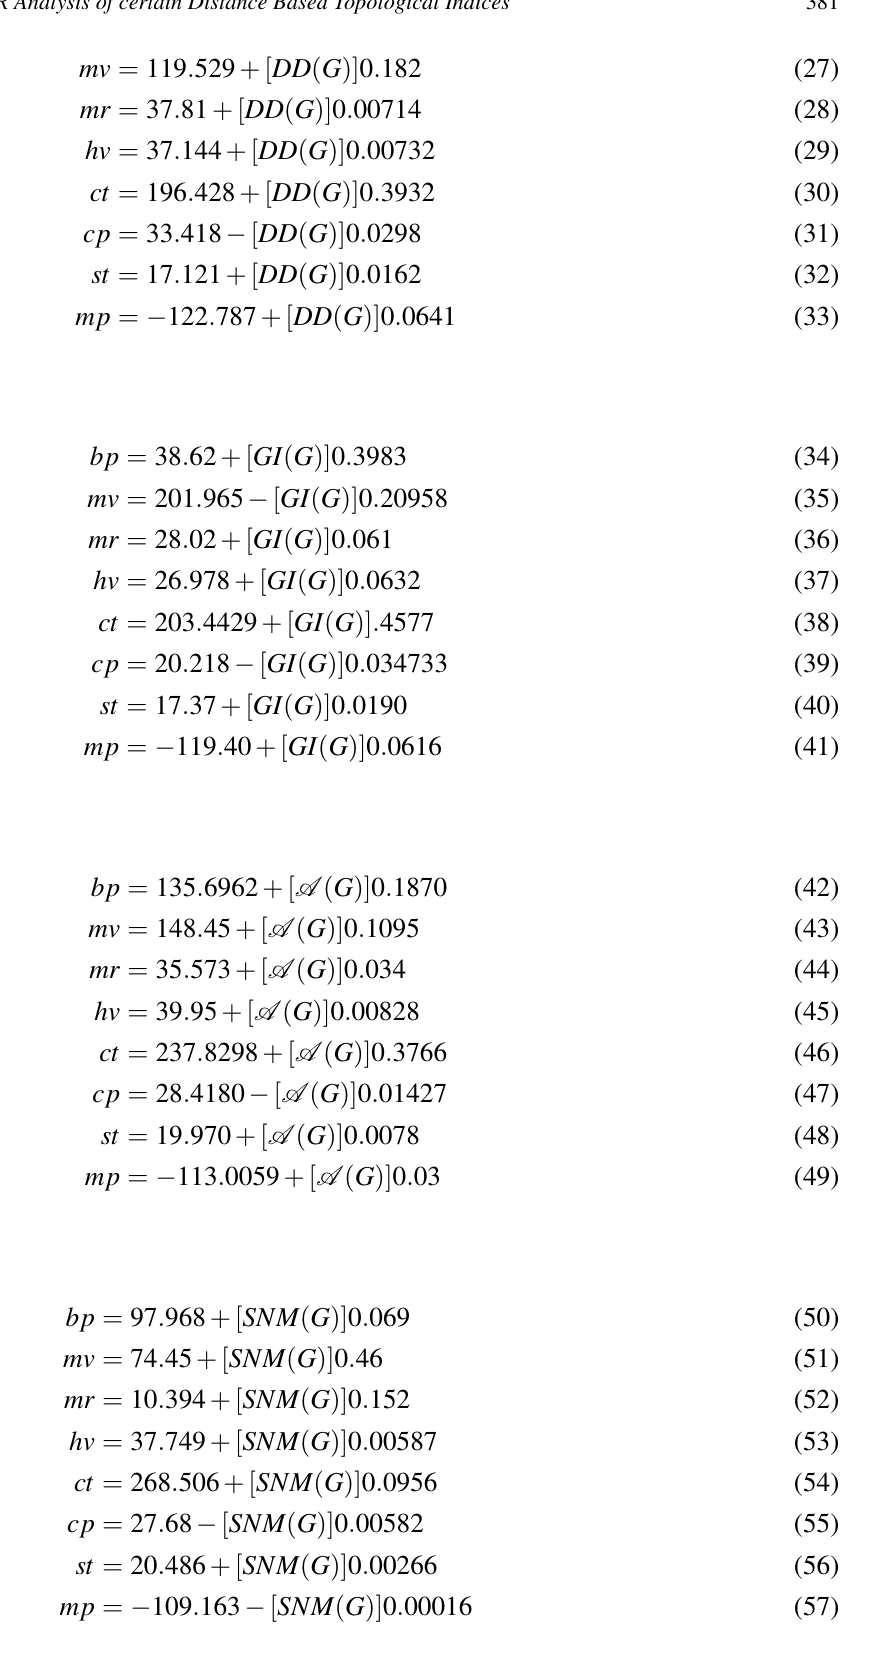
Table 3. Statical parameters for the linear QSPR model for Wiener